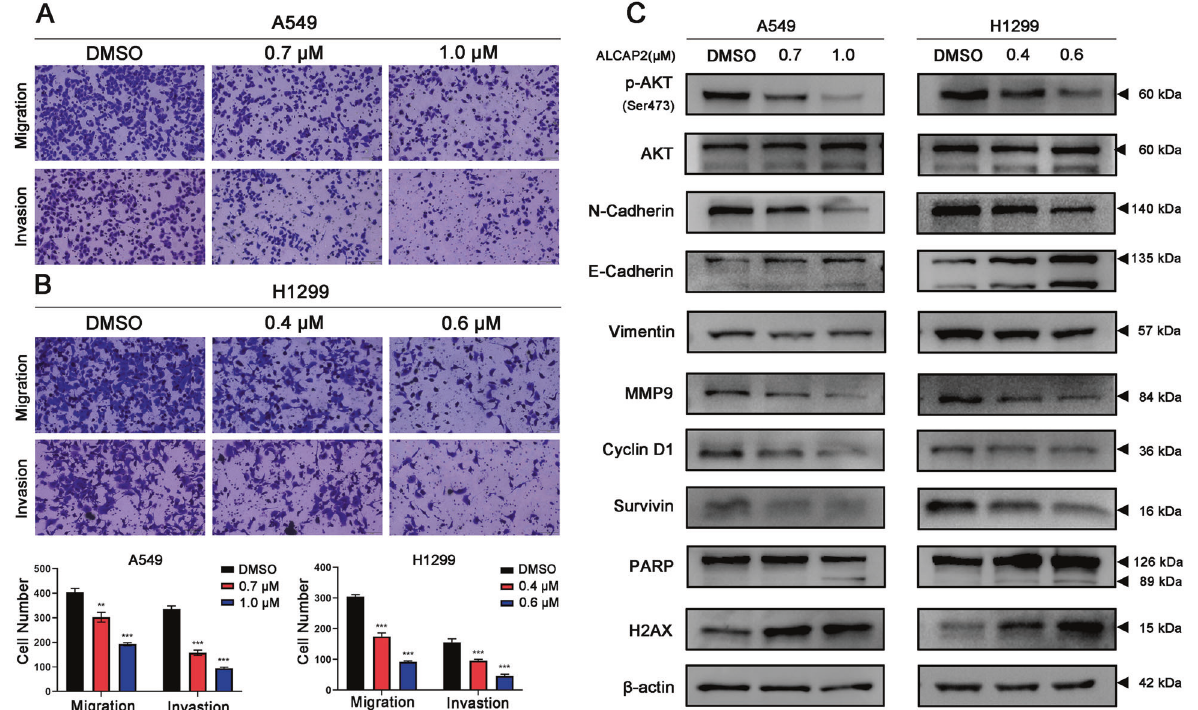
Fig. 3 ALCAP2 suppresses the migration and invasion of LUAD cells. A , B Representative images showing the results of Transwell cell migration and invasion assays of A549 and H1299 cells treated with or without ALCAP2. C The protein expression of N-cadherin, E-cadherin, vimentin, MMP9, Akt, p-Akt, H2AX, cyclin D1, PARP and survivin in A549 and H1299 cells treated with or without ALCAP2 as determined by western blot analysis. The data were analysed by unpaired Student ’ s t-test, ** P < 0.01, and *** P <0.001 vs the